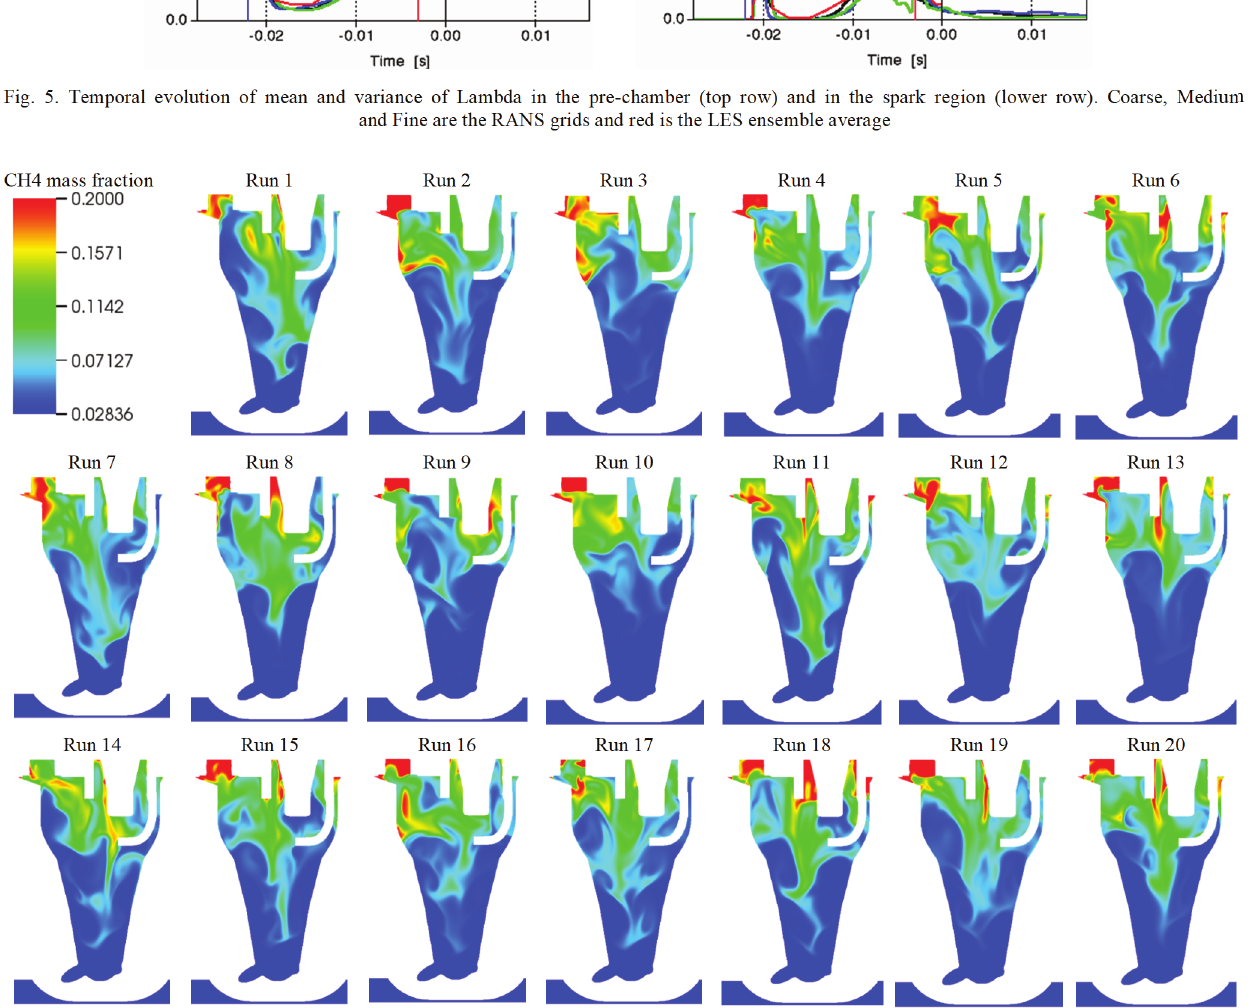
Fig. 6. Fuel mass fraction within the pre-chamber at spark time from 20 independent LES simulation